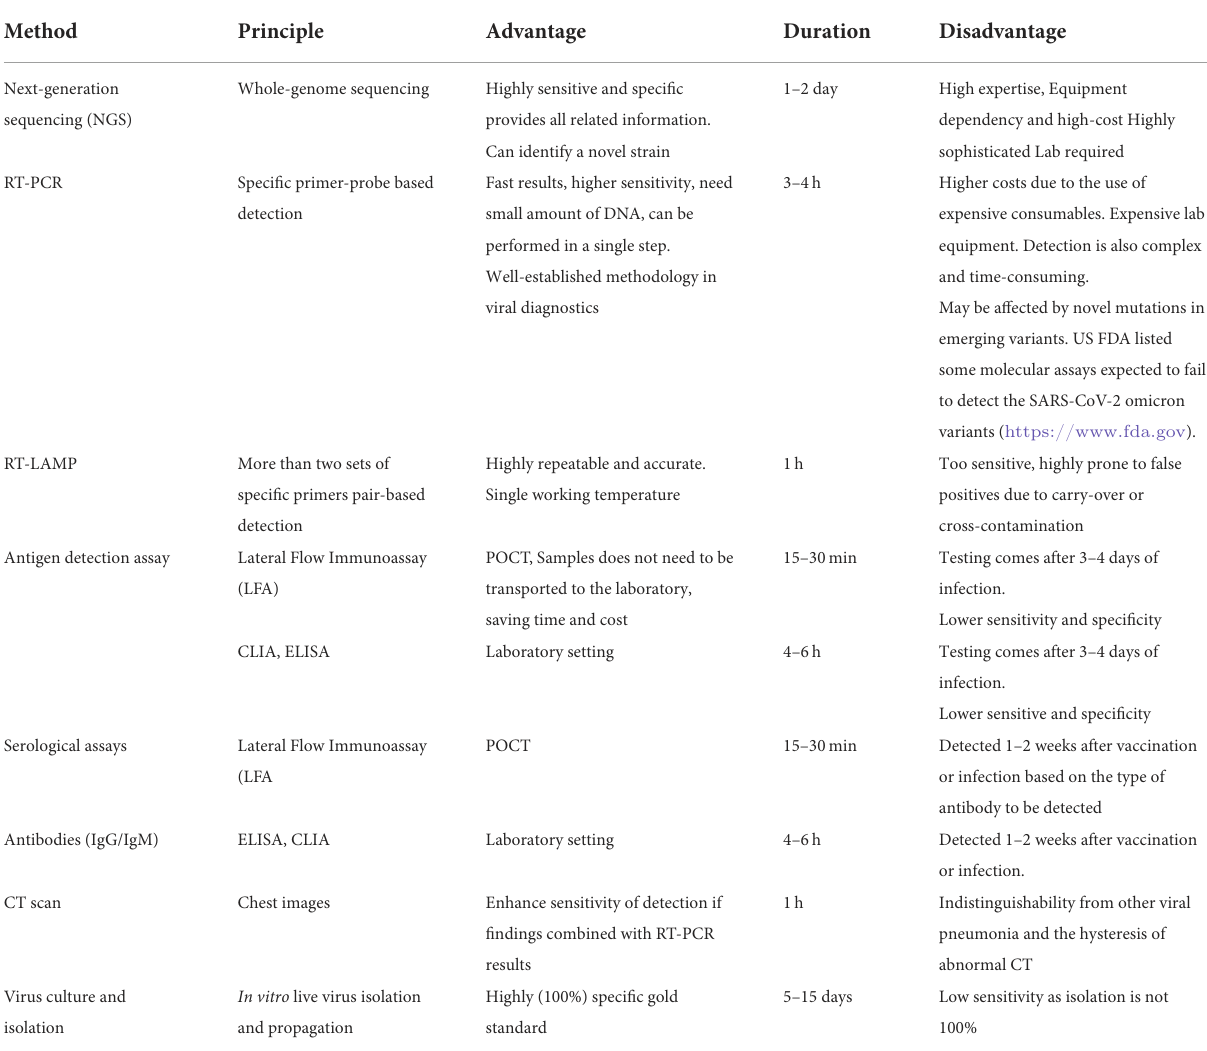
TABLE 3 Widely used diagnostics approaches for SARS-CoV-2